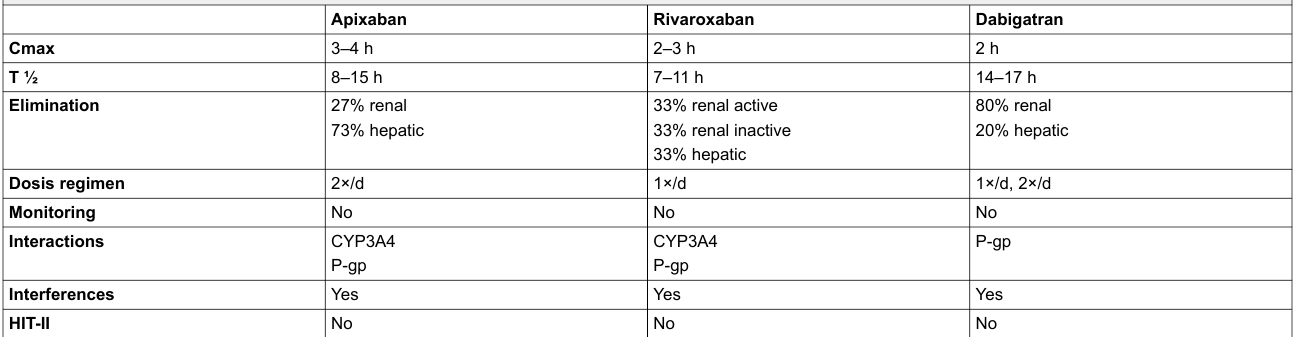
Table 1: Comparison of pharmacokinetic and pharmacodynamic properties of three new oral anticoagulants.